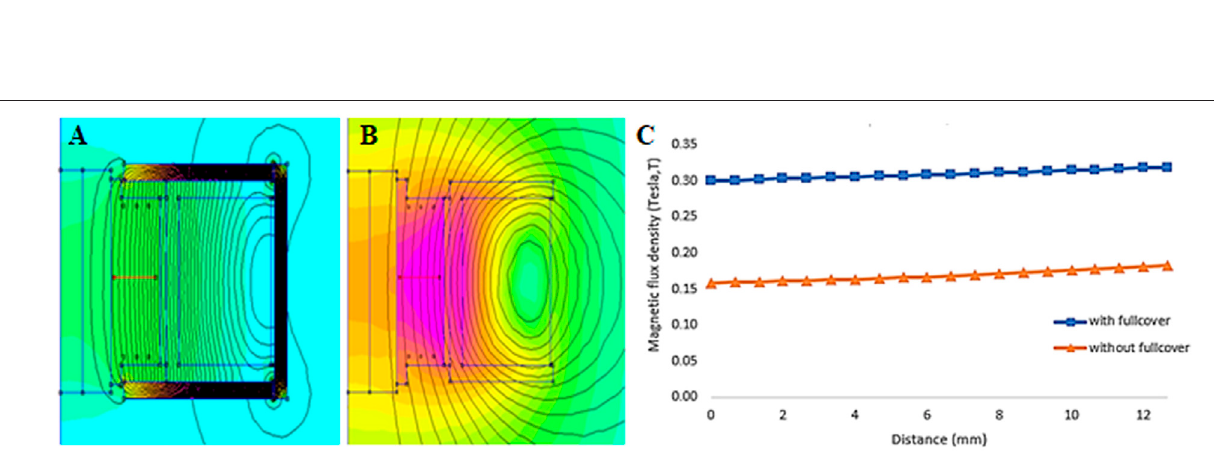
Frontiers in Materials |